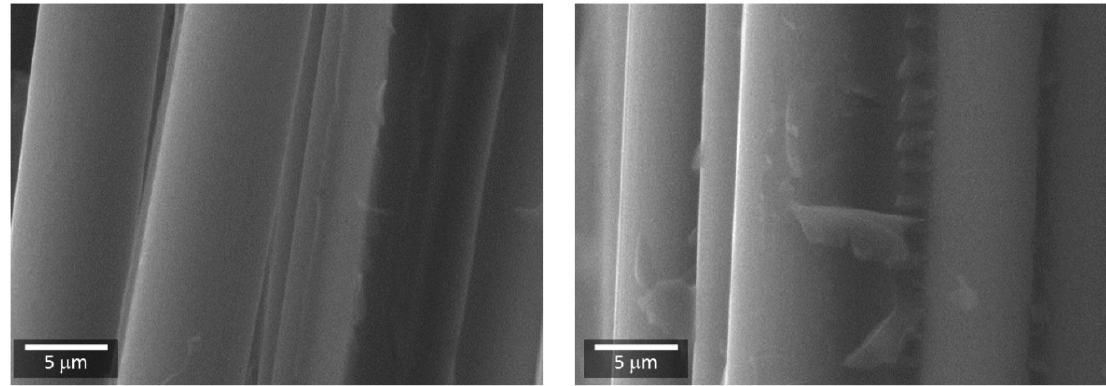
Figure 3. Scanning electron microscopy (SEM) images of the fracture surface of the laminates.